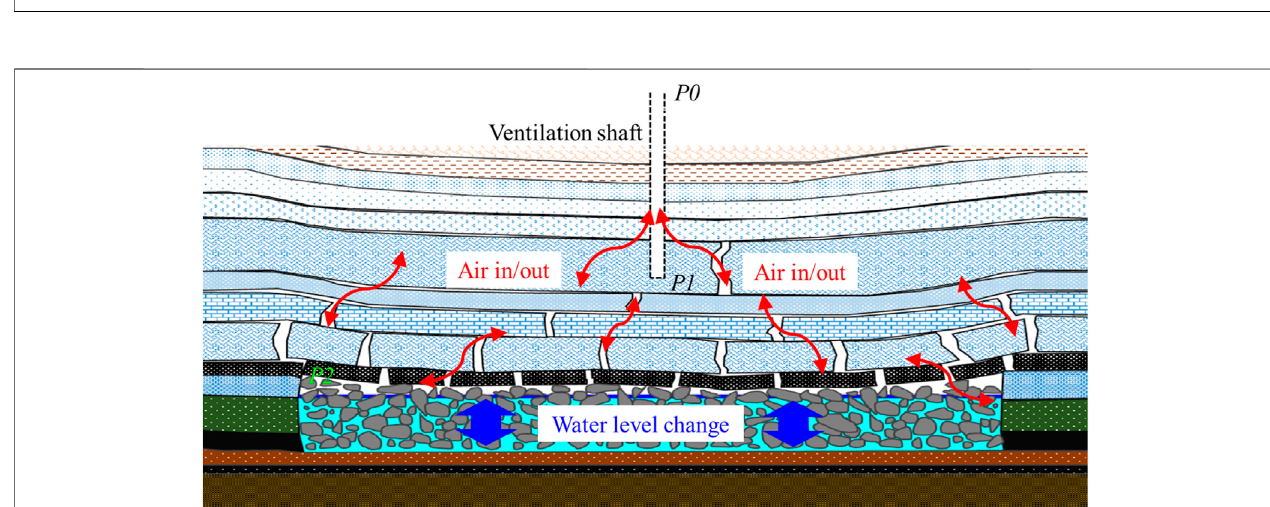
FIGURE 7 | Diagram for water-air exchange of the goaf reservoir during water pumping/injecting. P0 , P1, and P2 represent air pressure in the atmosphere, at the bottom of ventilation shaft, and at the far endpoint within the goaf, respectively.